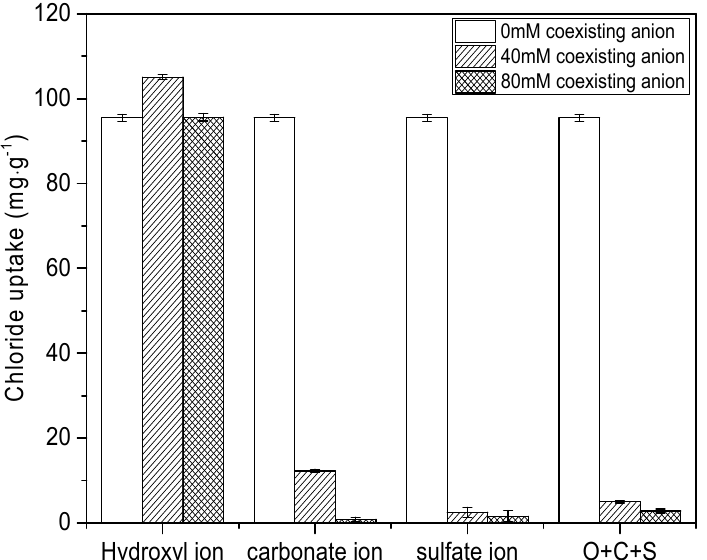
Figure 8. Effect of interference anions (i.e., OH − , CO 32 − and SO 42 − ) on chloride uptake of CAL-60 (temperature = 25 °C; CAL/NaCl solution = 10 g/L; initial chloride ion concentration and pH was set as 80 mmol/L and 7, respectively).